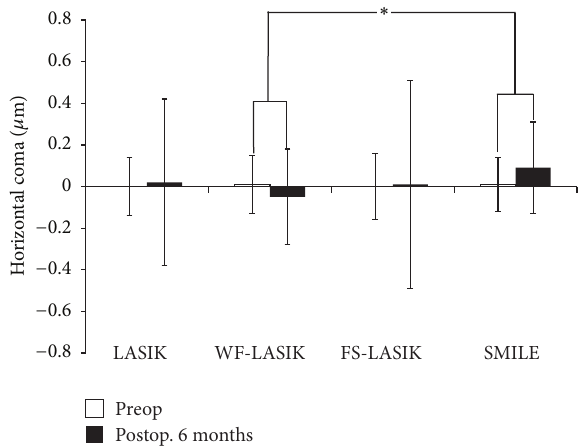
Figure 3: Comparison of the horizontal coma changes in four groups. Comparison of the induced horizontal coma between small incision lenticule extraction and wavefront-guided LASIK ( ∗ 𝑃 value is 0.001). Positive and negative values indicate an average positive or negative shift, respectively, in horizontal coma relative to preoperative values.